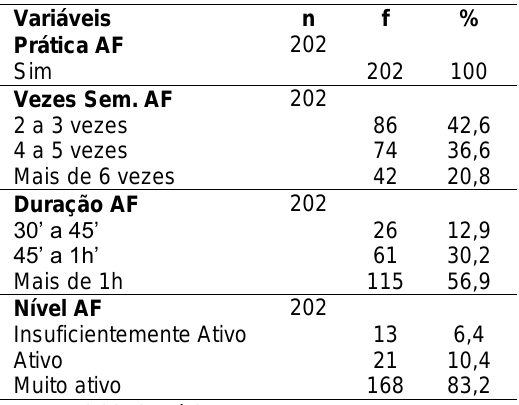
Tabela 1. Prática do surfe pelos surfistas.